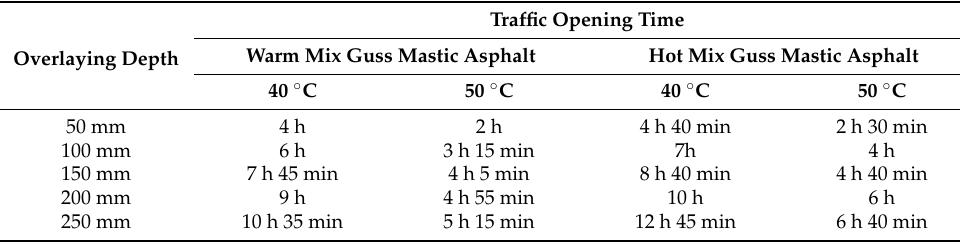
Table 8. Time required from construction to traffic